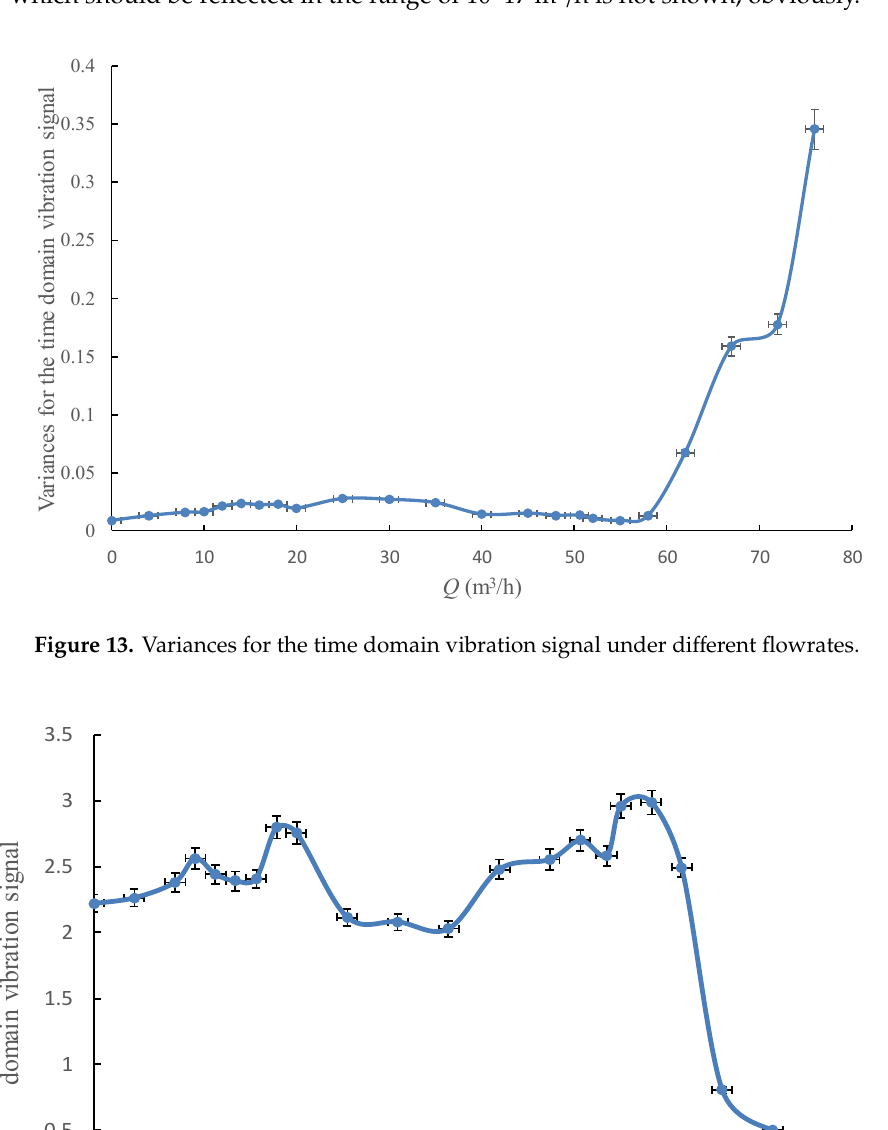
Figure 12. Standard deviation for the time domain vibration signal under different flowrates.